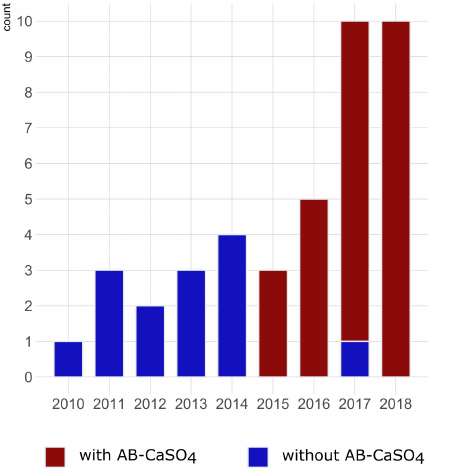
Figure 2. Graphical illustration of the number of cases of DAIR procedures for hip PJIs included per year in the study and color- coded depending on the application of antibiotic-loaded CaSO 4 (AB-CaSO 4 ). AB-CaSO 4 was introduced in our department in 2015. The change happened progressively, with the last DAIR pro- cedure performed without AB-CaSO 4 at the beginning of 2017. This does not appear on this figure, as cases operated without AB- CaSO 4 during the transition period fulfilled the exclusion criteria of this study. The increase in cases during the last few years may be indicative of a shift towards DAIR procedures induced by the obviously favorable results with addition of AB-CaSO 4